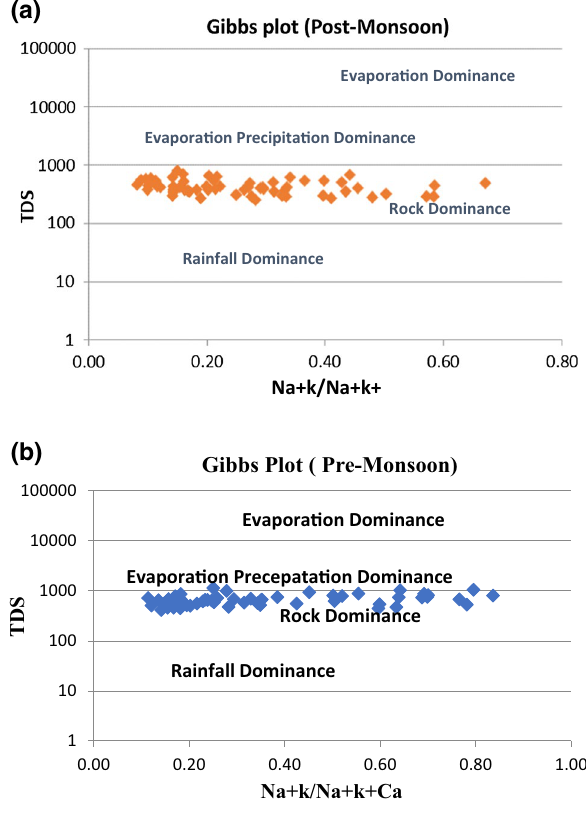
Fig. 7 a Gibbs plot of POM 2014. b Gibbs plot of PRM